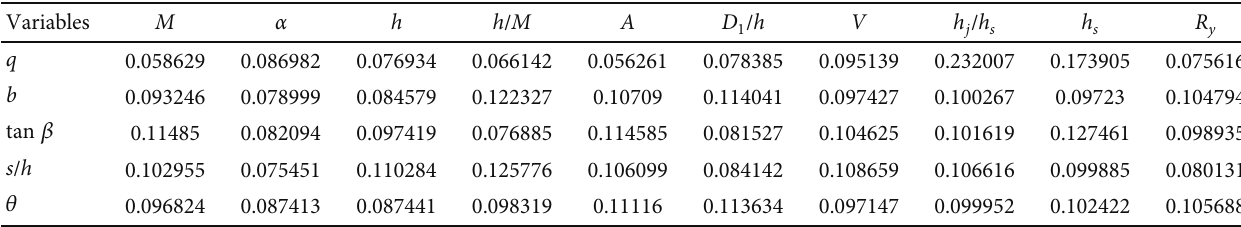
Table 2: OOB errors of each geological mining condition and each PIM